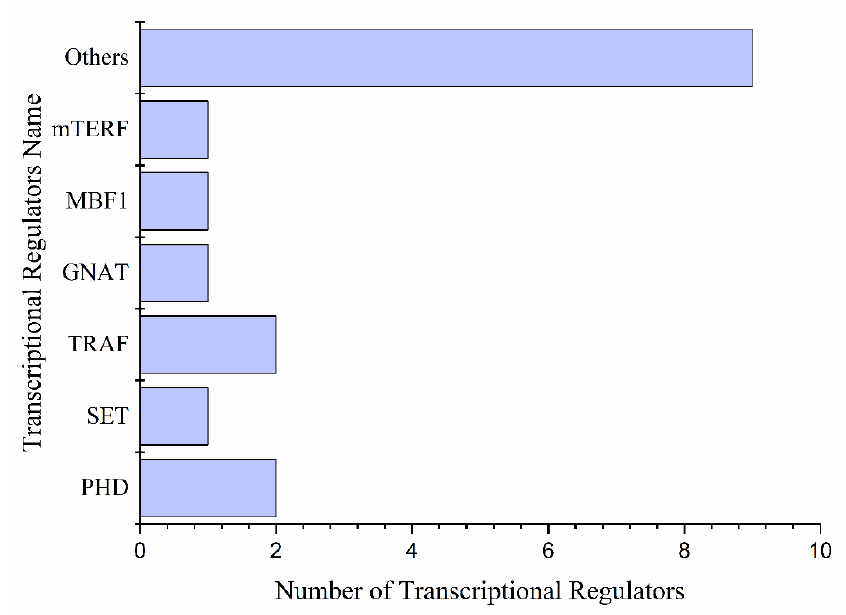
Figure 7. Transcriptional regulators are differentially expressed under drought stress.